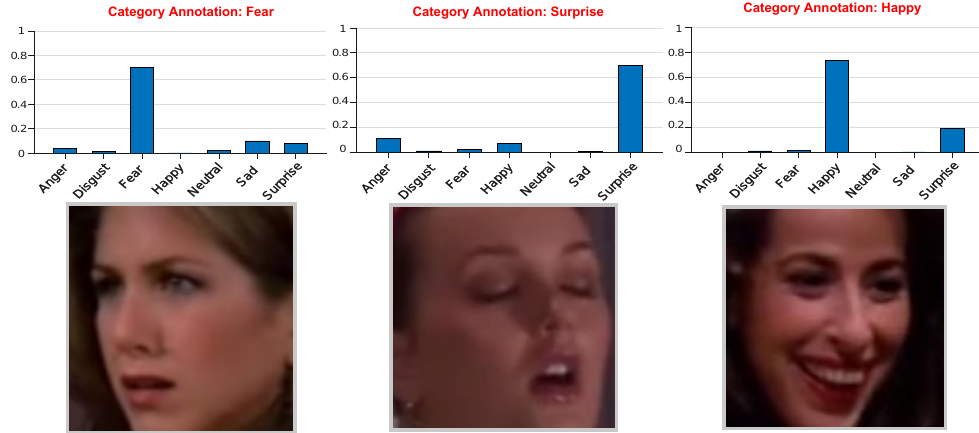
Figure 1. Human facial expressions, in reality, can be regarded as a combination of basic expressions. The label distributions on the facial images are the output of the ResNet-50 network trained on facial regions of the CAER-S